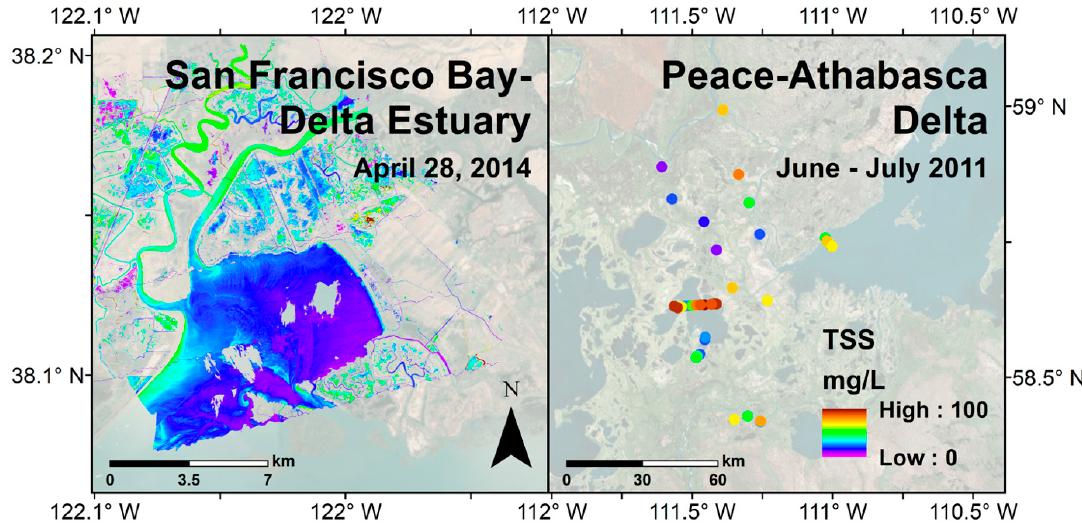
Figure 8. Total suspended solids (TSS, mg / L) retrieval result maps from the ( a ) San Francisco Bay–Delta Estuary PRISM dataset and ( b ) Peace–Athabasca Delta field spectrometer sample points.